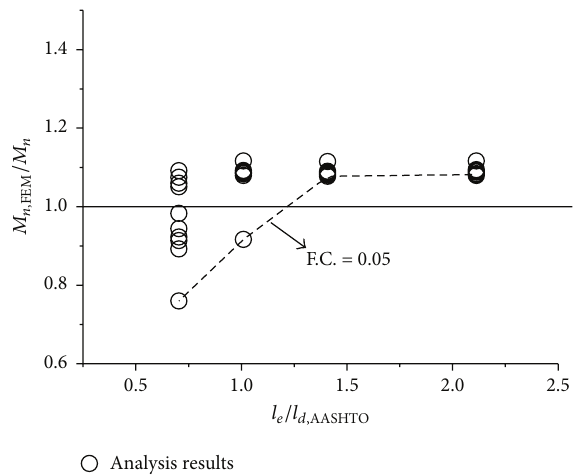
Figure 14: Variation in moment capacity of the connection with embedment length of